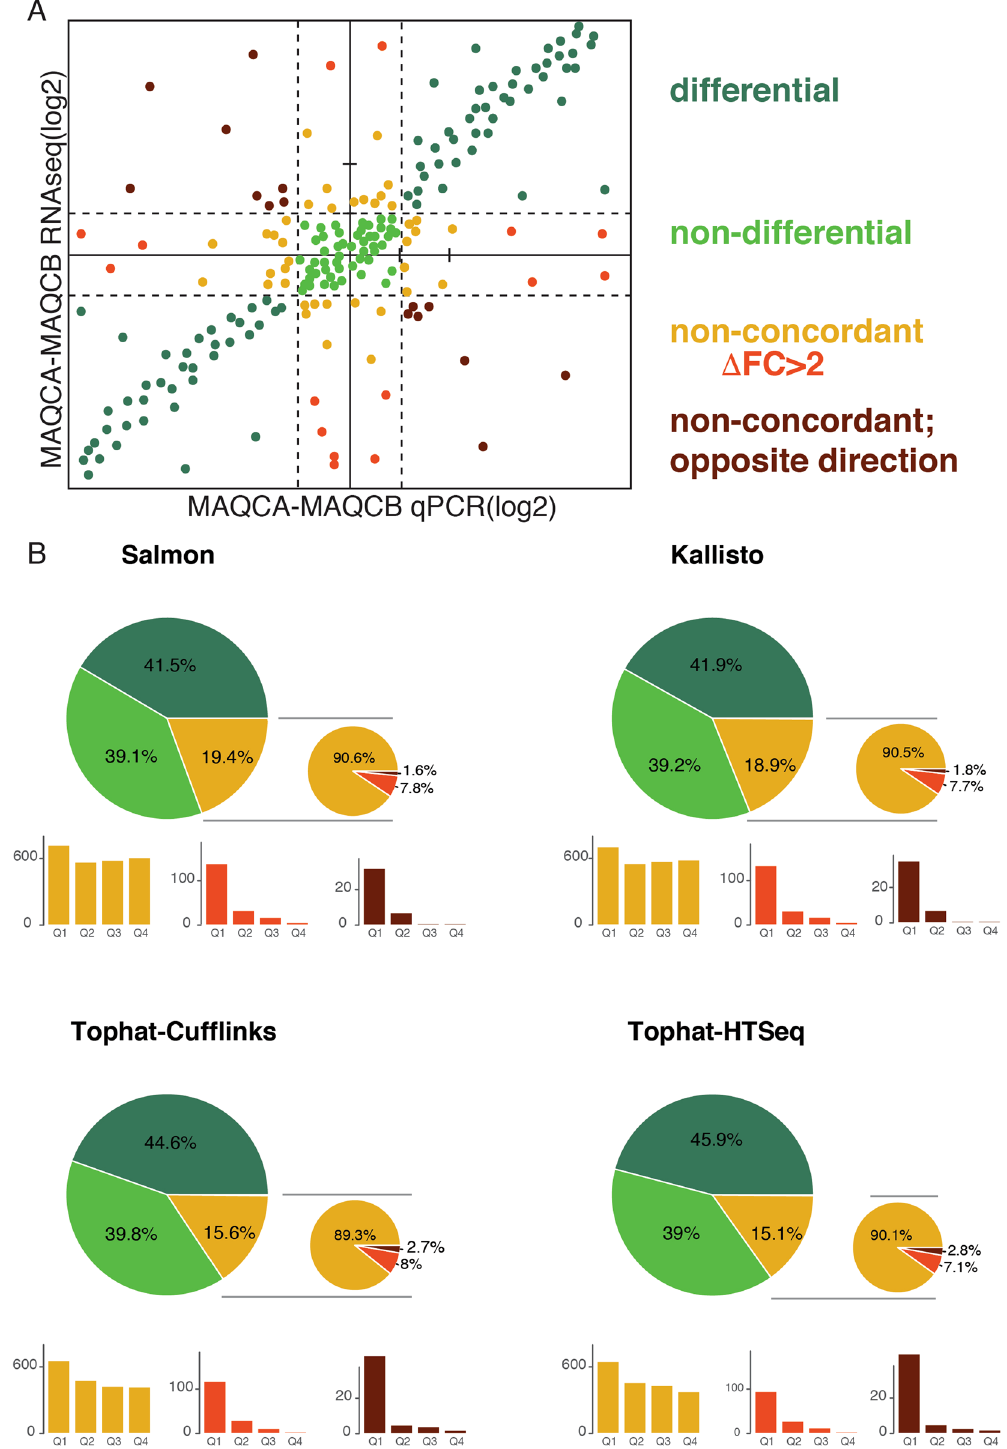
Figure 4. Quantification of non-concordant genes reveals that the numbers are low and similar between workflows. ( A ) A schematic overview of different classes of genes, used for further analysis, by means of a dummy example. The concordant genes between RT-qPCR and RNA-seq are either differentially expressed or non-differential for both datasets. The non-concordant genes are split into three groups, those with a ∆ FC < 2, ∆ FC > 2 and the ones with a FC in the opposite direction. ( B ) The percentages of genes in each of the above- described classes is shown for each workflow. For the non-concordant genes, distribution across expression quartiles (Q1 = lowest 25%) is shown. Results are based on RNA-seq data from dataset